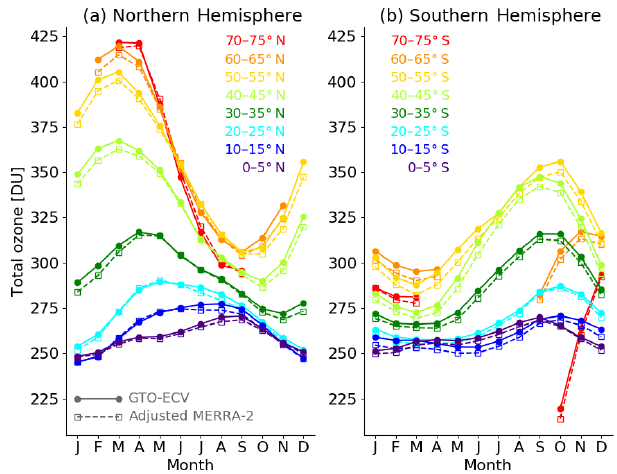
Figure 3. Comparison of the seasonal cycle of zonal mean total ozone columns from GTO-ECV (solid curves with filled circles) and adjusted MERRA (dashed curves with open squares) for dif- ferent 5 ◦ wide latitude bands in the Northern Hemisphere (a) and Southern Hemisphere (b) . The annual cycles have been calculated using the entire period